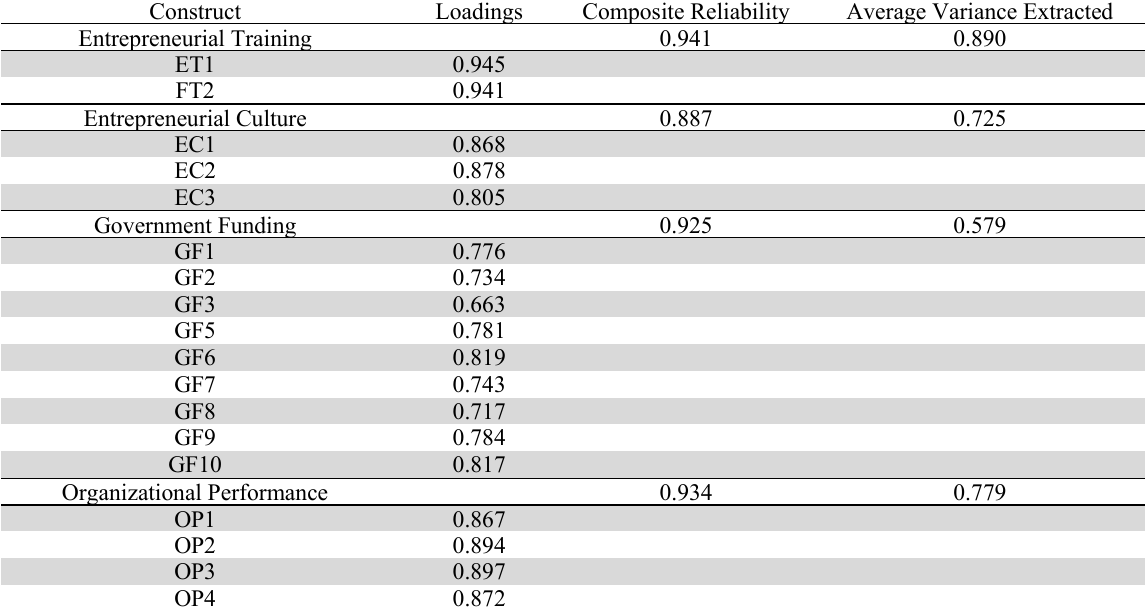
Factor Loadings and Reliability Scores